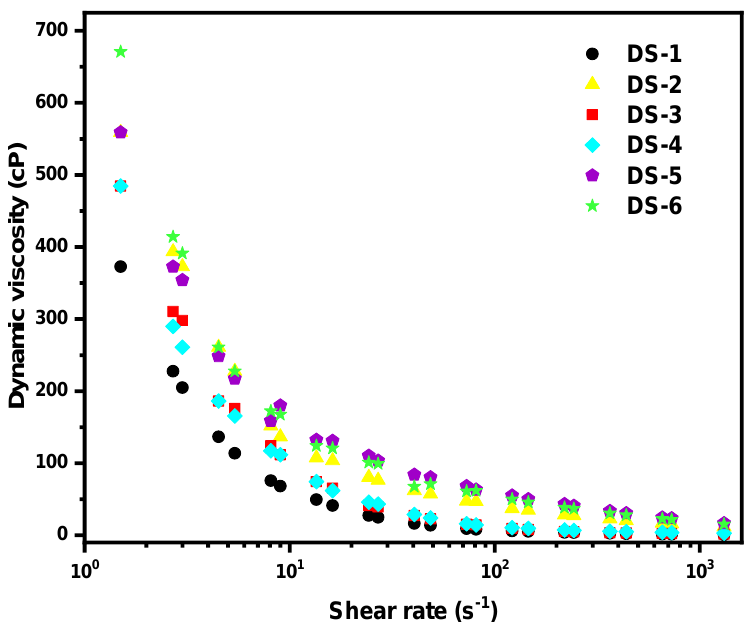
Figure 1. Viscosity of the decontaminating solutions.